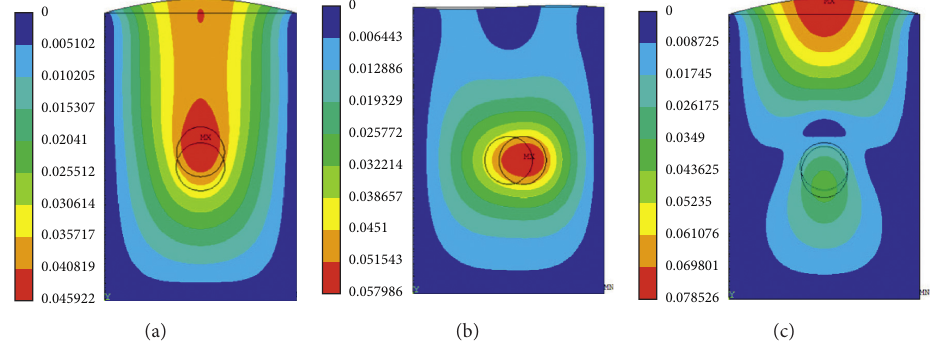
Figure 7: First 3-order mode shapes of polymer cutoff wall with moderate damage in the middle part. (a) First vibration mode. (b) Second vibration mode. (c) Third vibration